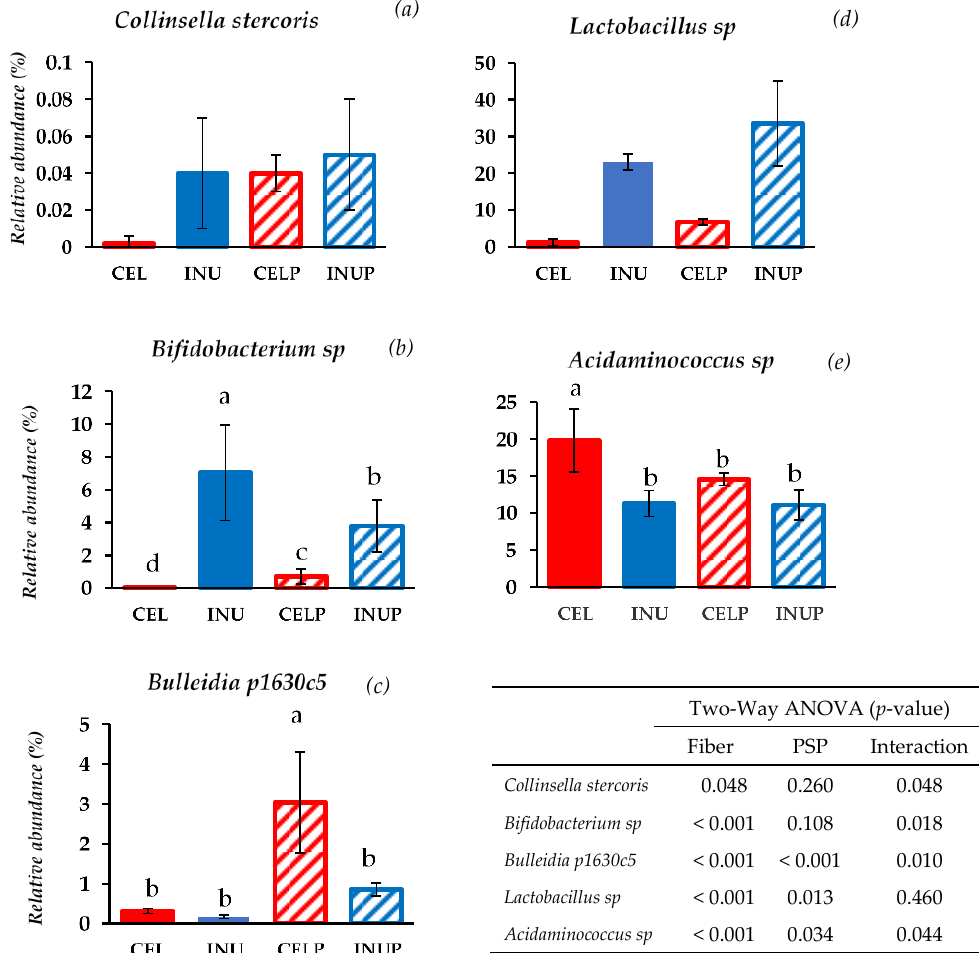
Figure 3. Relative abundances at species level: Collinsella stercoris ( a ), Bifidobacterium sp. ( b ) , Bulleidia p1630c5 ( c ), Lactobacillus sp. ( d ), and Acidaminococcus sp. ( e ) after 48 h of treatment during in vitro colonic fermentation of 3% cellulose (CEL), 3% cellulose + 0.16% PSP (CELP), 3% inulin (INU), and 3% inulin + 0.16% PSP (INUP). Statistical significance amongst the groups was determined by two-way ANOVA analysis to assess the e ff ect of fiber (CEL and INU), PSP and their interaction. P < 0.05 was considered to be statistically significant. If the variance was observed in the main e ff ect of the interaction, Tukey’s test was used for this comparison ( p < 0.05). Table 2. Changes in short chain fatty acid (SCFA) during in vitro fecal fermentation.